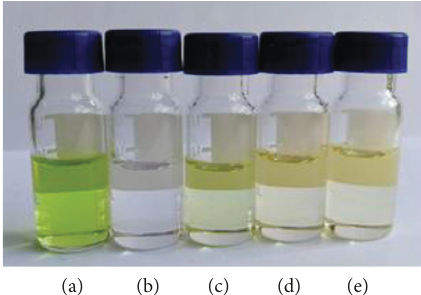
Figure 3: Photography of cleanup efficiency using different d-SPE absorbents: (a), without cleanup; (b), MWCNTs-COOH; (c), C18; (d), PSA; (e), GCB.